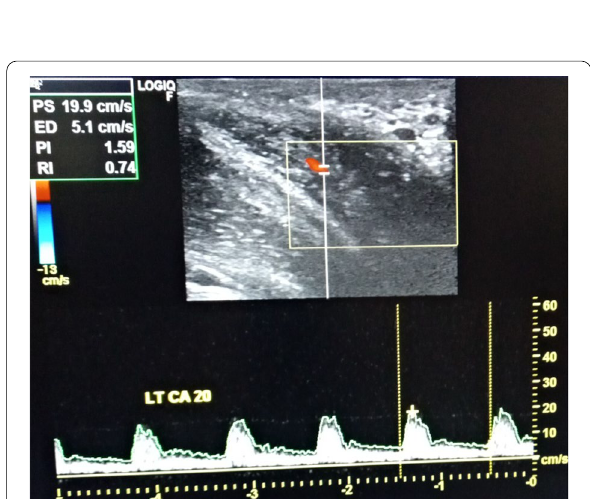
Fig. 4 Spectral waveform of the left cavernosal artery of a patient at 20 min showing reduced arterial inflow with a PSV of 19.9 cm/s, feature connoting arteriogenic ED